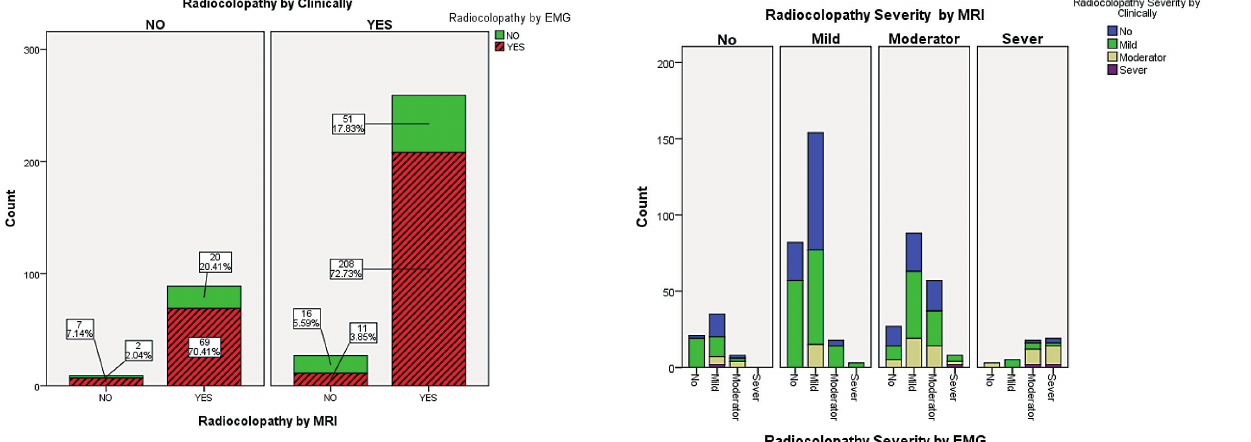
Figure 1. Frequency distribution of agreement in individuals with radiculopathy based on EMG and MRI diagnosis and clinical